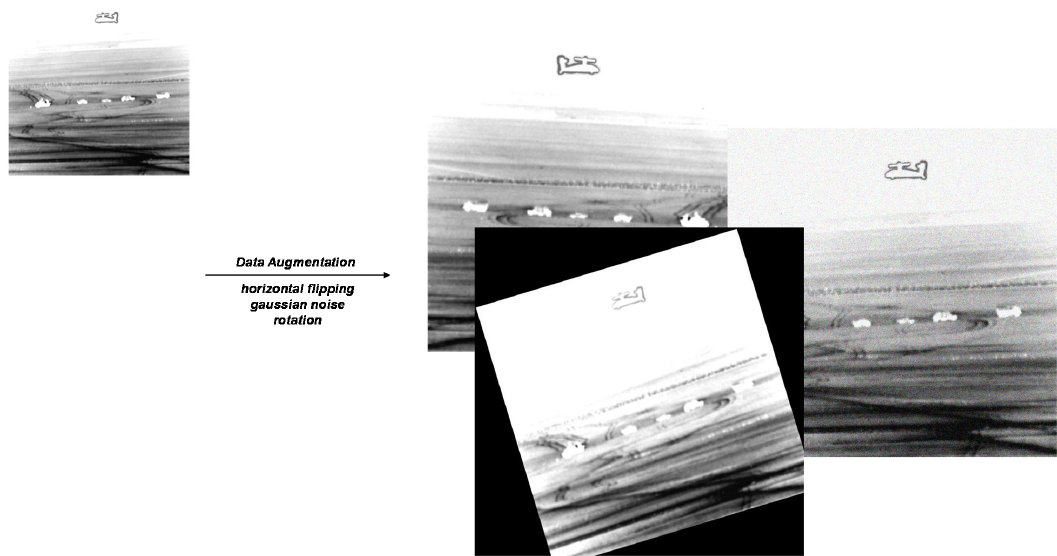
Figure 7. The data augmentation for each image, including horizontal flipping, Gaussian noise, rotation. Table 1. The definition of true positive (TP), false positive (FP), true negative (TN), and false negative (FN) [54] .